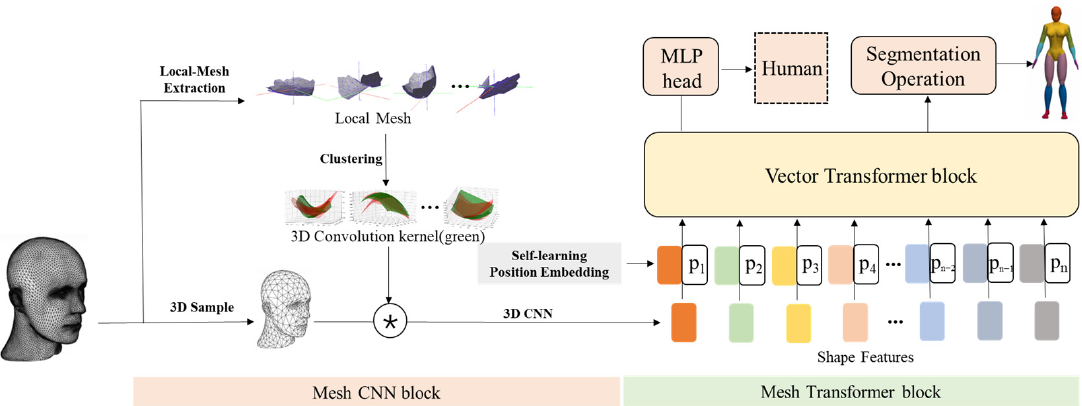
Figure 1. MixFormer network structure and 3D target processing flow. MixFormer can be viewed as two blocks: a mesh CNN block and mesh transformer block. A mesh CNN block can acquire local surface features of the 3D mesh model and use them as Token input to the mesh transformer block. The block learns global features by building dependencies between local surface features. The learned features can be used for downstream tasks such as classification and segmentation.